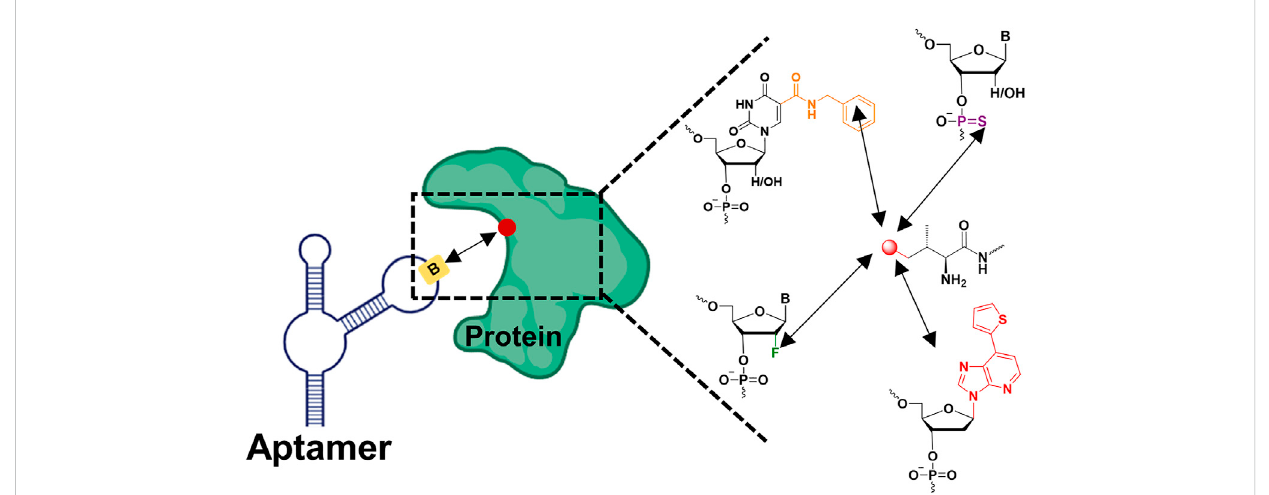
FIGURE 1 Chemically modi fi ed aptamers for improving binding af fi nity to the target protein via enhancing non-covalent bonding (the red dot represented amino acid residues on the protein, the yellow rectangle represented modi fi ed nucleotides on the aptamer, the black arrow represented non-covalent